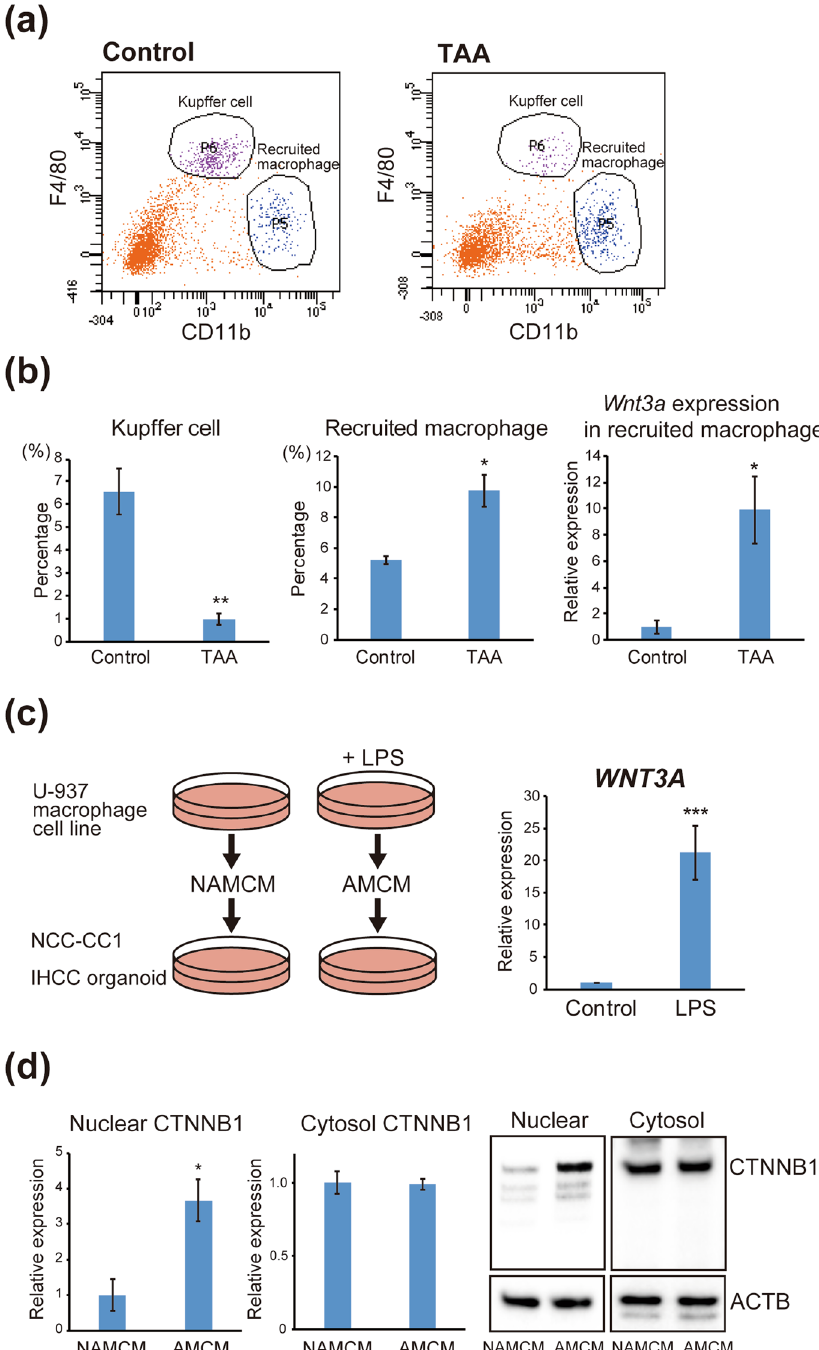
Figure 8. Activation of the Wnt signaling pathway by macrophages recruited to the liver by inflammation. ( a ) Flow cytometry analysis to determine the proportions of resident macrophages (Kupffer cells) and macrophages recruited to the liver of TAA-administered mice. Kupffer cells were isolated as F4/80 high and CD11b low cells, and recruited macrophages as F4/80 low and CD11b high cells. ( b ) The percentages of Kupffer cells and recruited macrophages in the liver of control mice and TAA-administered mice (left and middle). Relative expression of Wnt3a derived from recruited macrophages in the liver of control mice and TAA-administered mice (right). ( c ) Scheme of the LPS stimulation assay (left). U937 human macrophage cells were activated by treatment with 5 μ g/ml LPS for 48 h. U-937 cells treated with PBS were used as a negative control. Activated macrophage conditioned medium (AMCM) and non-activated macrophage conditioned medium (NAMCM) were collected. The NCC-CC1 IHCC cells and IHCC organoids were then treated with AMCM or NAMCM for 48 hours. Relative expression of WNT3A in the U937 human macrophage cell line untreated or treated with LPS was examined (right). ( d ) Western blot analysis of nuclear and cytosolic β -catenin (CTNNB1) in NCC-CC1 cells (left) and IHCC organoids (right) treated with NAMCM or AMCM. β -Actin (ACTB) was used as an internal